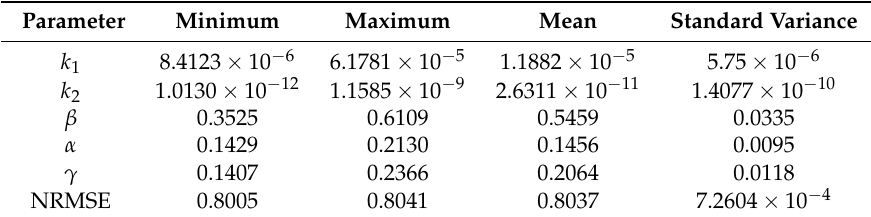
Table 2. Descriptive statistics of the fitted